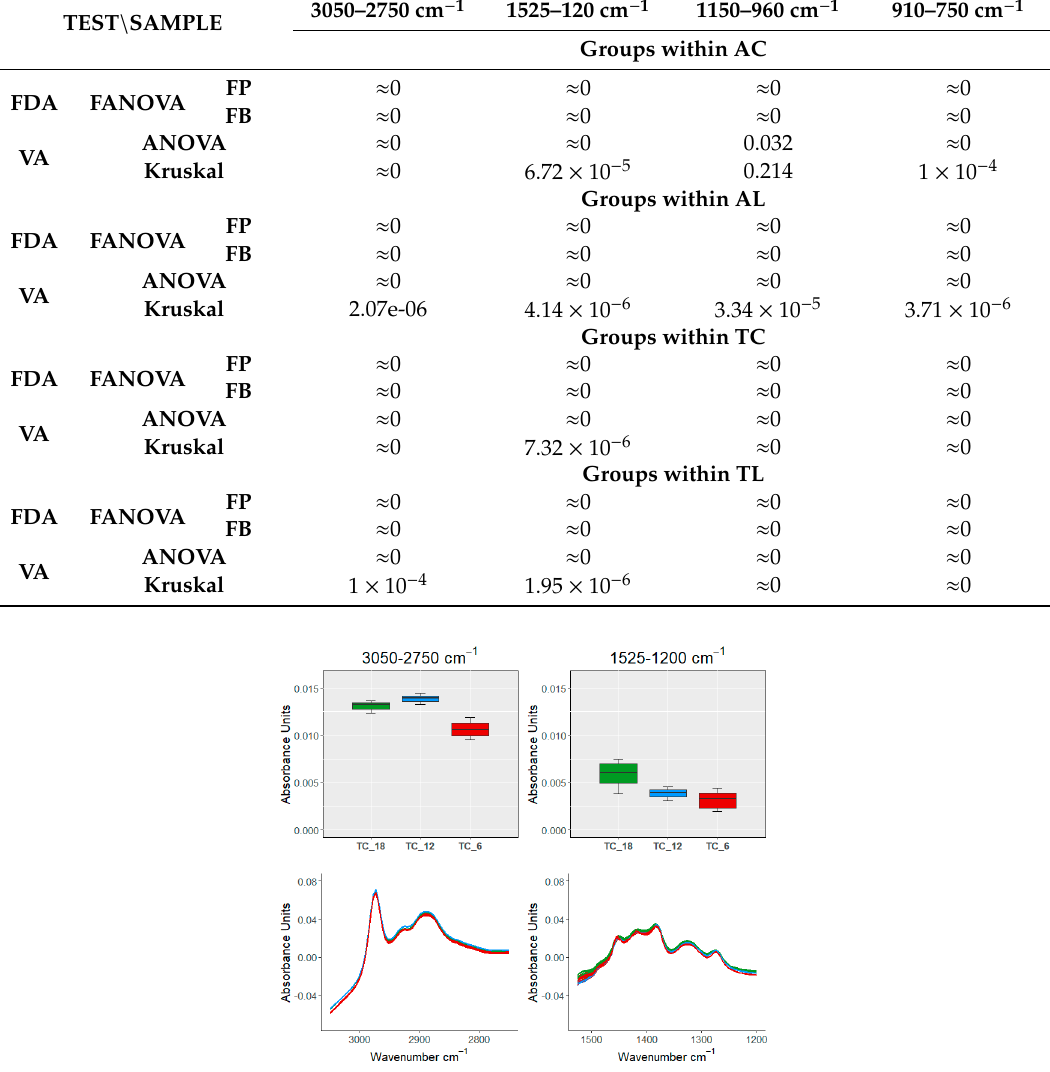
Table 5. Results of the similarity contrast between the three ageing times (18 months, 12 months, and 6 months), depending on the ageing technology. Functional results (FDA) are based on functional ANOVA (FANOVA) using two di ff erent tests (FP: permutation test based on a representation of the base function, FB: F test with a reduced bias estimation method). In addition, the results of the ANOVA and Kruskal’s test representing the vectorial results (VA) are shown. All the results are p -values based on a 5% significance level.